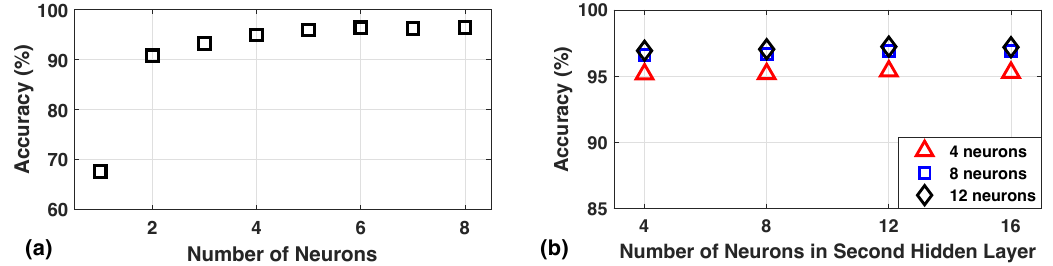
Figure 6. Accuracy of ( a ) one hidden layer, and ( b ) two hidden layer networks with varying number of neurons in the hidden